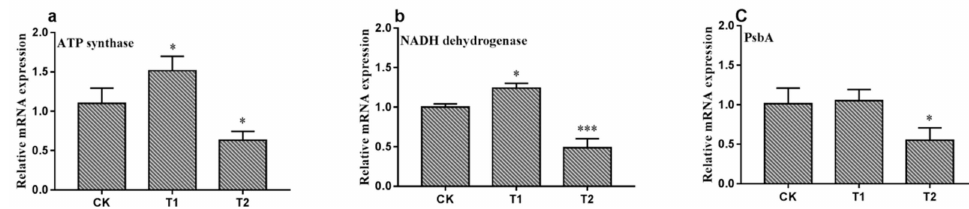
Figure 5. The mRNA expression of ATP synthase ( a ), NADH dehydrogenase ( b ), and PsbA ( c ) in C. pyrenoidosa exposed to 0.1 mg.L − 1 BPA (T1) and 10 mg.L − 1 BPA (T2). C. pyrenoidosa without exposure to BPA were used as control group. The data were expressed as mean ± standard deviation (SD) compared with control group * p < 0.05 vs. control group, *** p < 0.001 vs. control